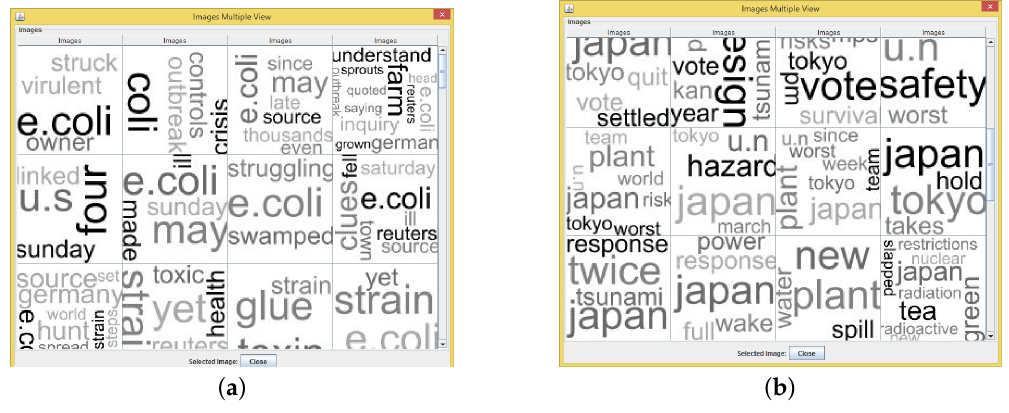
Figure 11. Analysis of the NEWS-8 dataset: ( a ) some tag clouds from Selection A from Figure 6 and ( b ) some tag clouds from Selection B from Figure 6.